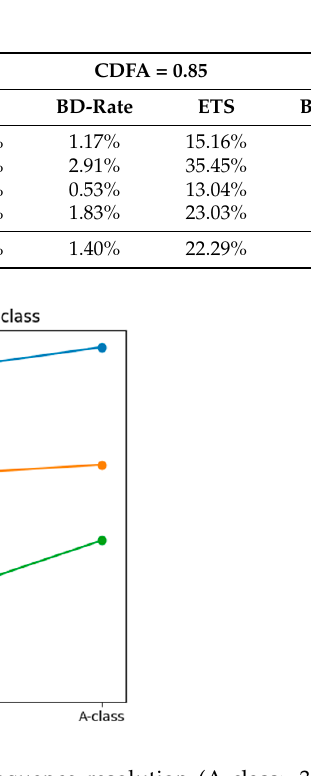
Figure 10. ETS performance according to sequence resolution (A-class: 3840 × 2160, B-class: 1920 × 1080, C-class: 832 × 480, D-class: 416 × 240).